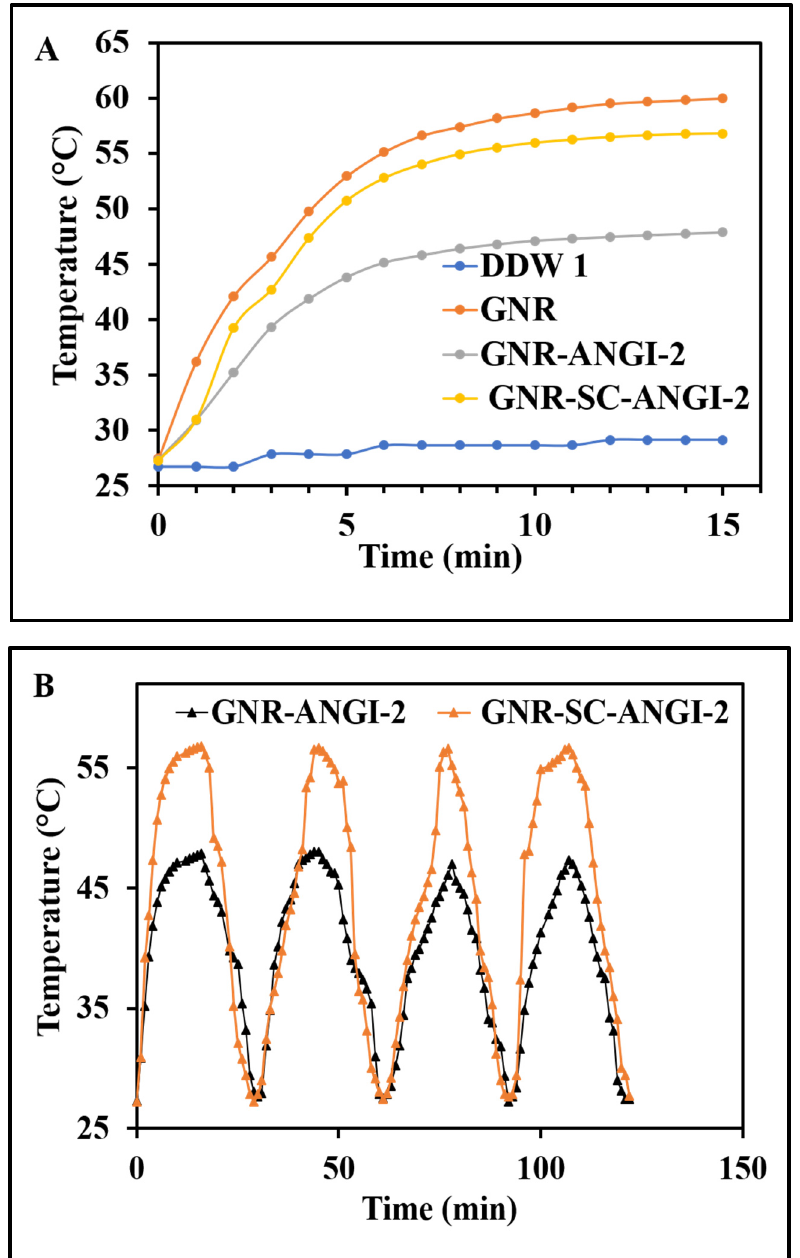
Figure 2. Temperature elevation profile of GNR-CTAB and GNR-peptide conjugates. ( A ) Temperature elevation of DDW, GNRs, GNR-ANGI-2, and GNR-SC-ANGI-2 conjugates at 100 μ g/mL Au ion concentration with 1 W cm − 2 in deionized water. ( B ) Reusability of GNR-ANGI-2 and GNR-SC-ANGI-2 evaluated by subjecting the GNR-peptide conjugates at 100 μ g/mL Au ion concentration to 4 cycles of temperature rising and lowering under 808 nm laser irradiation (on) for 15 min, followed by sham exposure for 15 min (off) in each cycle.